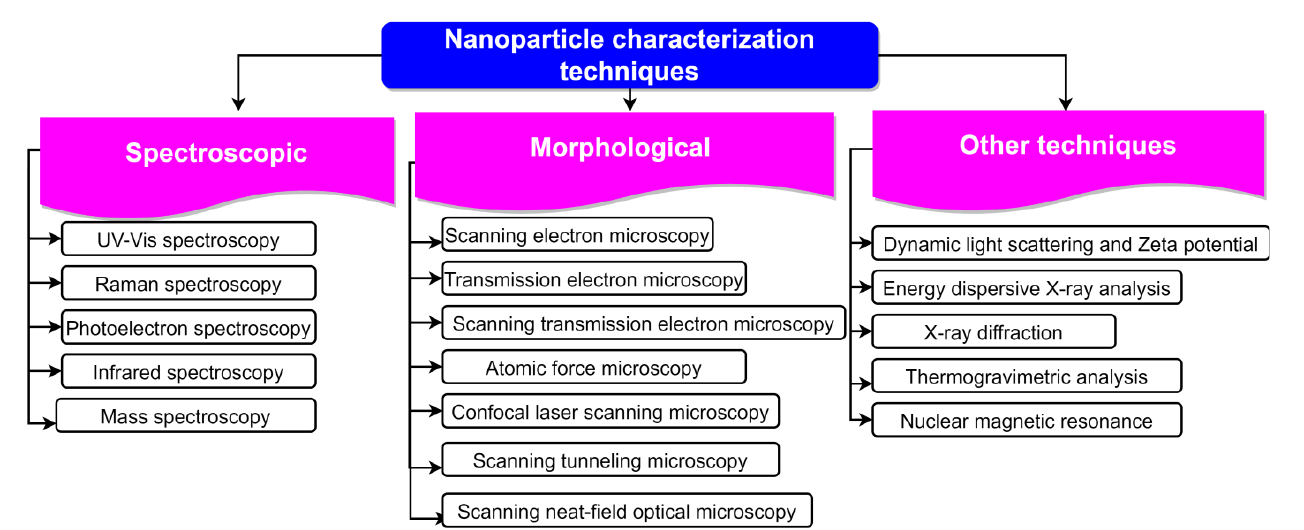
Figure 6. Different techniques employed for characterization of NPs.